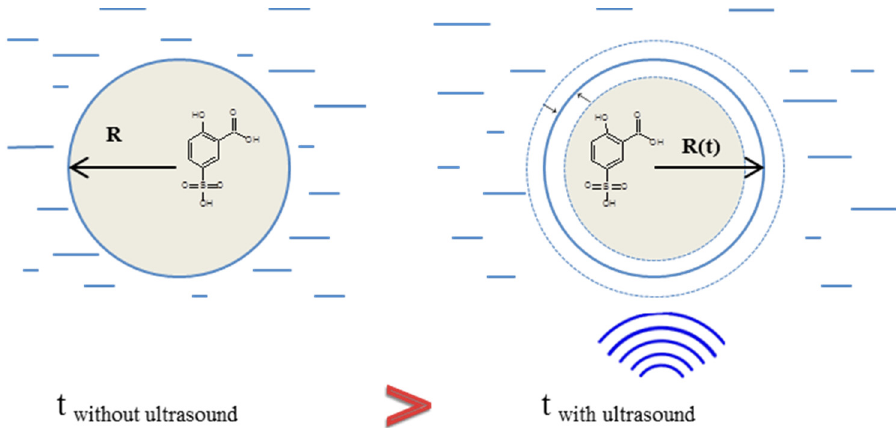
Figure 5. Positions of a drop in the absence of ultrasound and in the presence of variable pressure in the environment.